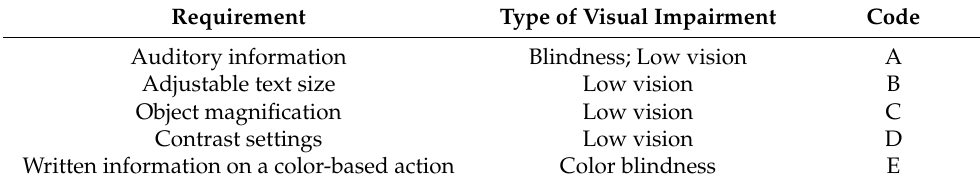
Table 1. Web accessibility requirements for visually impaired users.